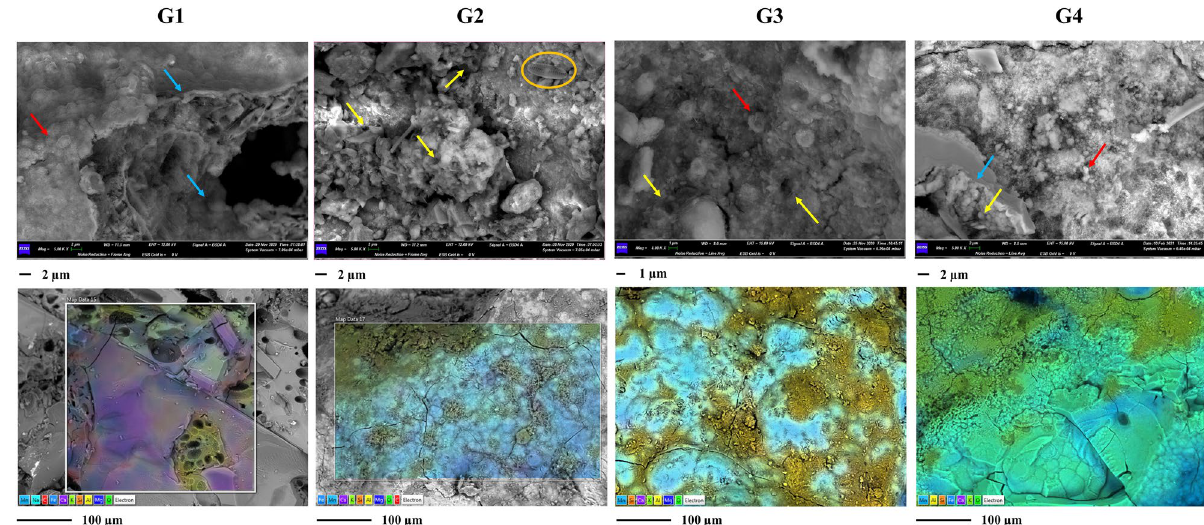
Figure 1. SEM–EDS investigations of gorge samples. Upper panels show the micrographs obtained by SEM observations. In the panels the putative microbial imprints are marked by yellow arrows, the microbial biofilms by blue arrows, and microbial mineralized structures by red arrows. The orange circle in sample G2 marks the presence of a diatom within the sample. Work distance (WD) = 8.5–11.5 mm; electron high tension (EHT) = 12–15 kV; Signal = BSD4 A (backscattered electrons); Magnitude = 5–8 K X (Scale bars are presented under each panel). Lower panels present the elemental maps obtained by EDS analyses. The microanalysis acquisitions were carried out at 12.00 kV (Scale bars are presented under each panel). Mn presence is underlined with light blue colour.